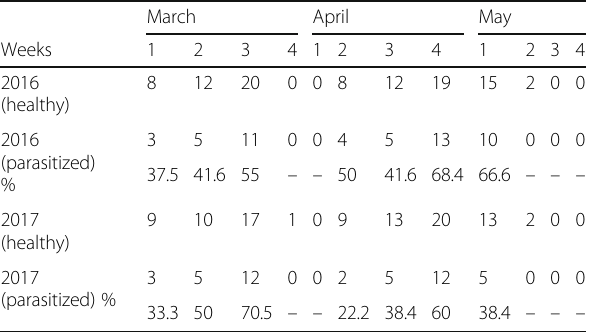
of D. silphoides on 25 flower or green seed bunches of